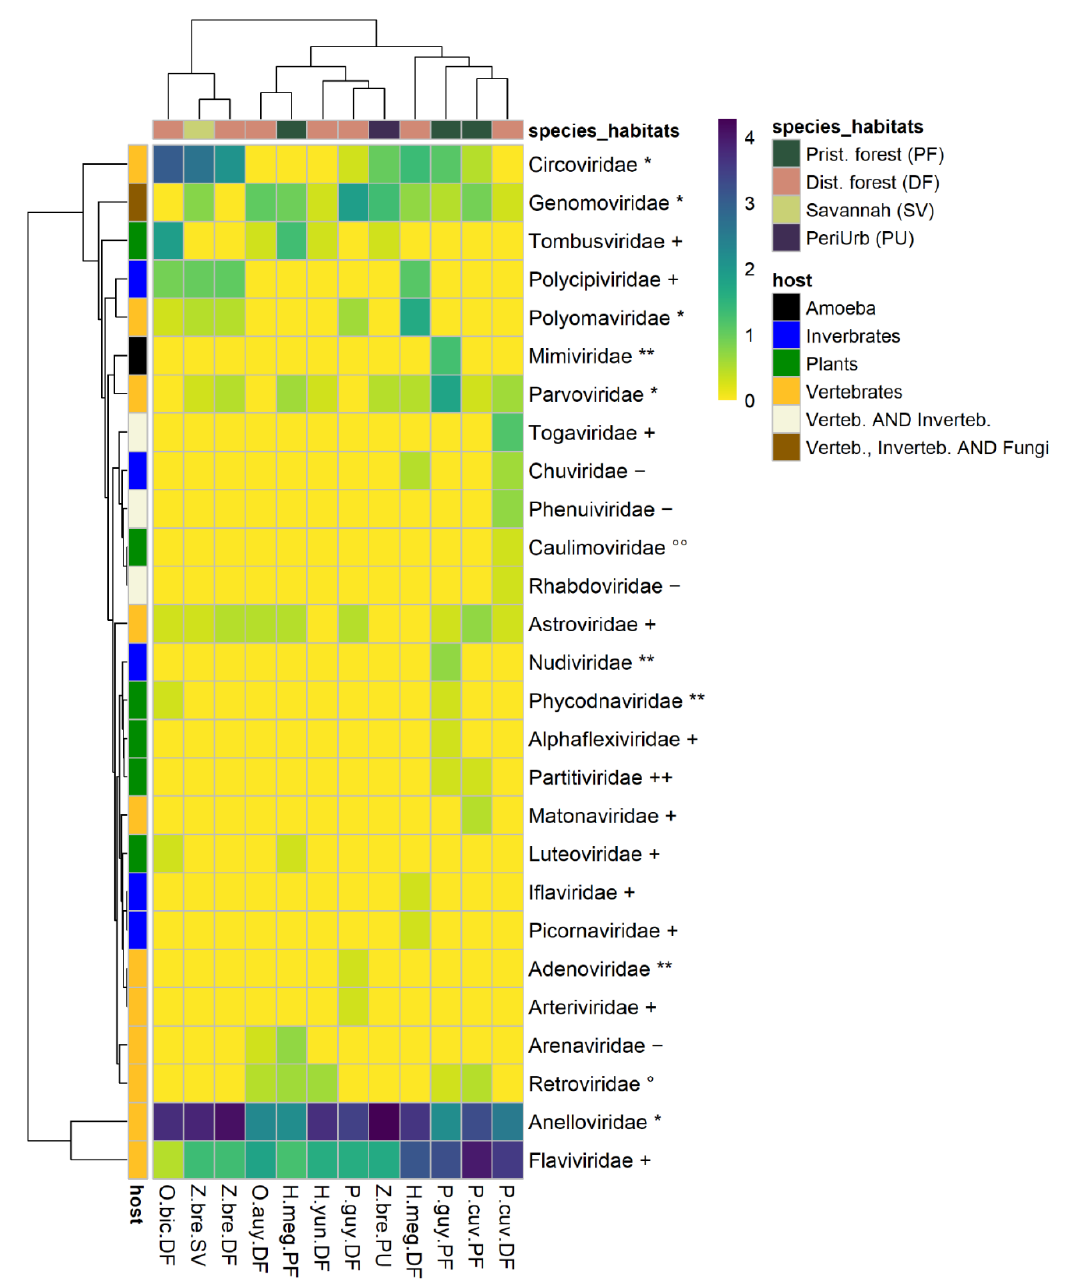
Figure 2. Heatmap of viral families’ numbers of contigs by species–habitat. Each cell representing a viral family in a species-habitat contains log (1 + N), (where N is the number of contigs assigned to a viral family in a species–habitat). The left row represents host-type (vertebrate, invertebrate, plants). Viral family names are marked with genome type, as follows: ** = dsDNA, * = ssDNA, ++ = dsRNA, + = ssRNA (+), − = ssRNA ( − ), °° = DNA-retrotranscribing, ° = RNA-retrotranscribing. P.guy.PF: Proechimys guyannensis from pristine forest, P.guy.DF: Proechimys guyannensis from disturbed forest , P.cuv.PF: Proechimys cuvieri from pristine forest, P.cuv.DF: Proechimys cuvieri from disturbed forest, H.meg.PF: Hylaeamys megacephalus from pristine forest, H.meg.DF: Hylaeamys megacephalus from pristine forest, Z.bre.SV : Zygodontomys brevicauda from savannah, Z.bre.DF: Zygodontomys brevicauda from disturbed forest, Z.bre.PU: Zygodontomys brevicauda from peri-urban areas.